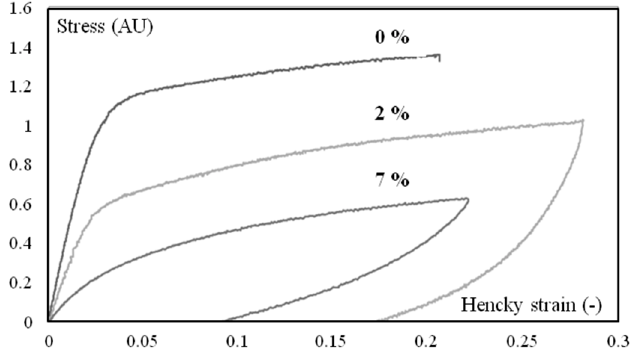
Figure 6. Loading-unloading stress vs. strain cycles under tension at 23 °C for three different water contents. The strain rate is 4 10 − 3 s − 1 . Samples were extracted in the first third of the plaques (close to the gate).